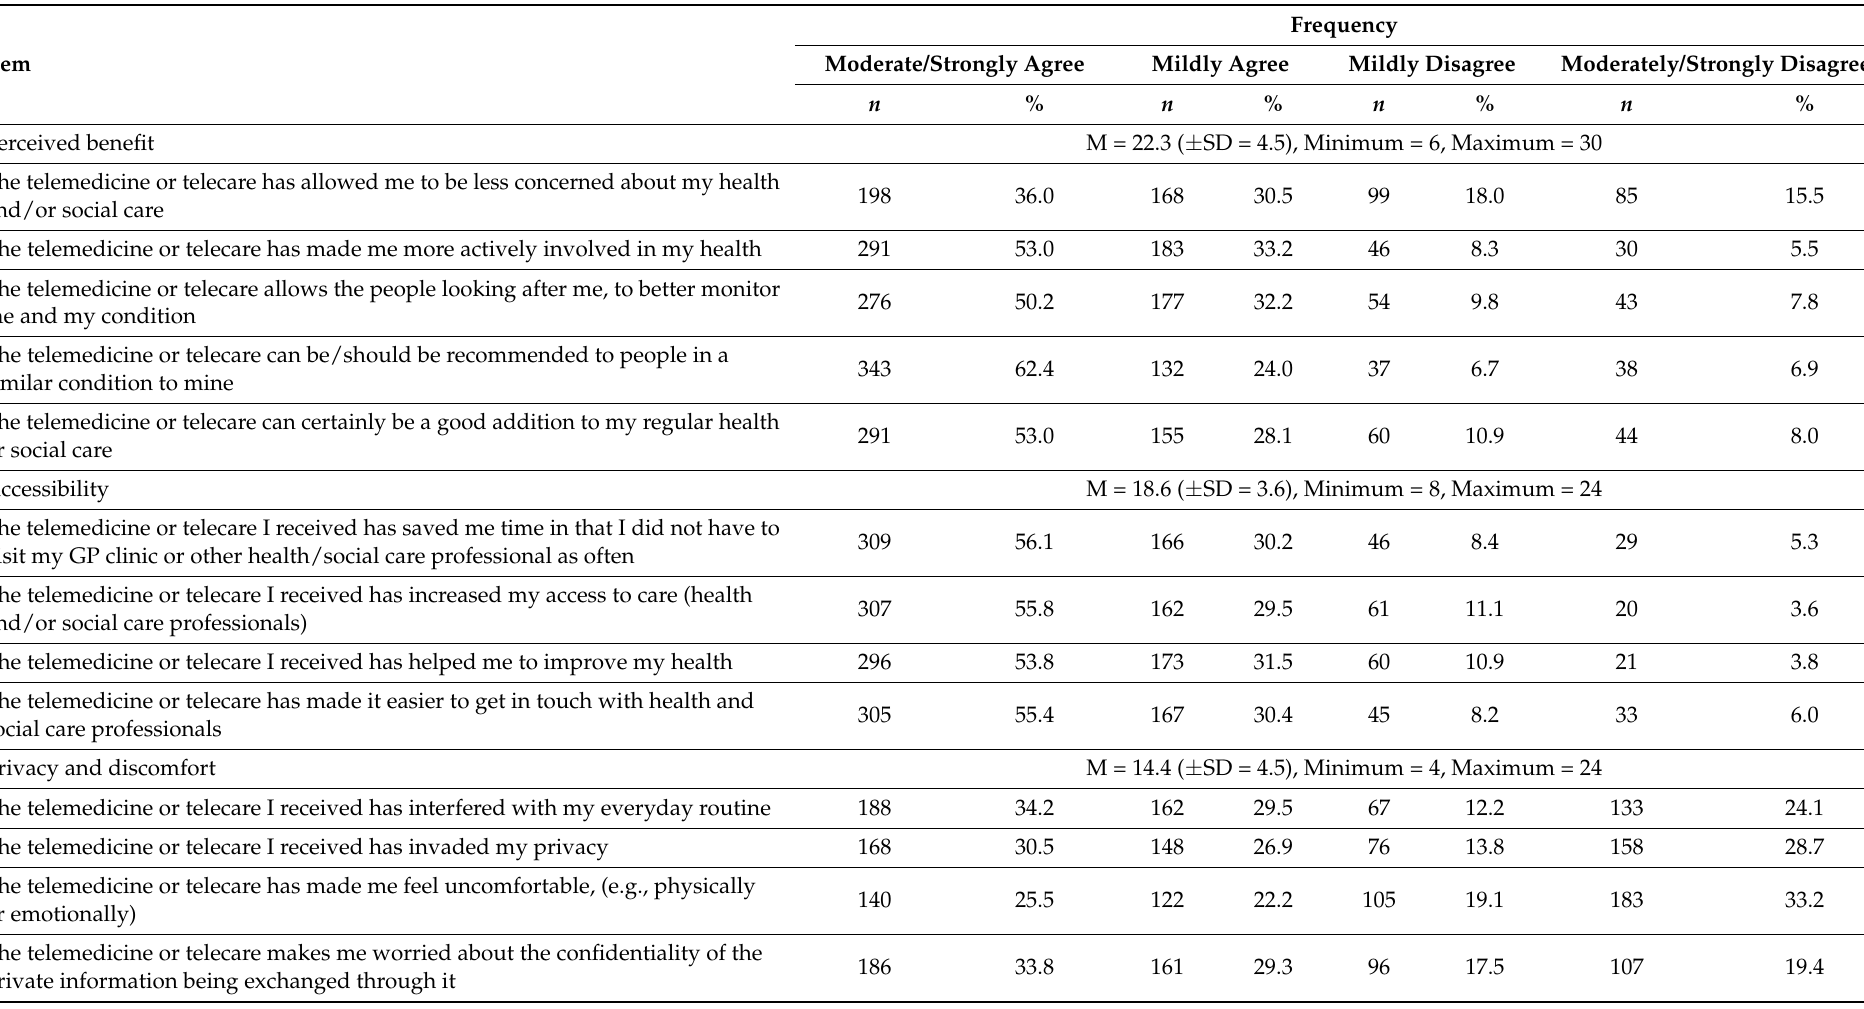
Table 3. Participants’ perceptions about different domains of telemedicine use ( n =